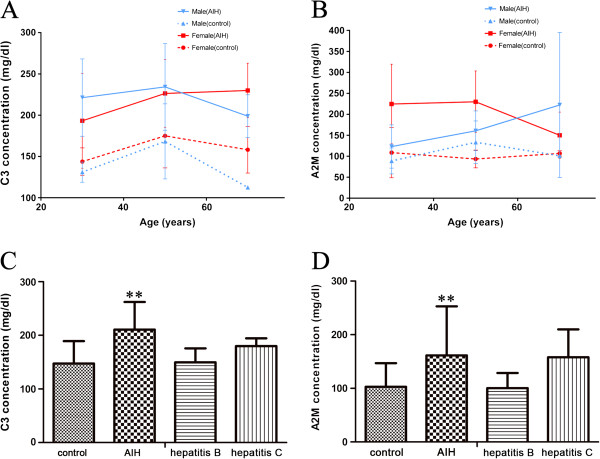
Serum C3 and A2M levels in AIH patients validated by ELISA. A-B. Serum C3 and A2M levels measured based on the gender and age of AIH patients . (Classified by gender, n = 10 for female control group and n = 16 for female AIH group; n = 9 for male control group and n = 18 for male AIH group. Classified by age in AIH group, n = 13 for patients with 20–40 years, n = 13 for the group with 41–60 years, and n = 8 for the group with 61–80 years. For control healthy group, n = 7 for 20–40 years’ group, n = 6 for 41–60 years’ group and n = 5 for 61–80 years’ group). C-D. Serum C3 and A2M levels measured in patients with different forms of hepatitis. (**P < 0.01 versus control samples, n = 10 for hepatitis B group, n = 10 for hepatitis C group and n = 19 for control group).